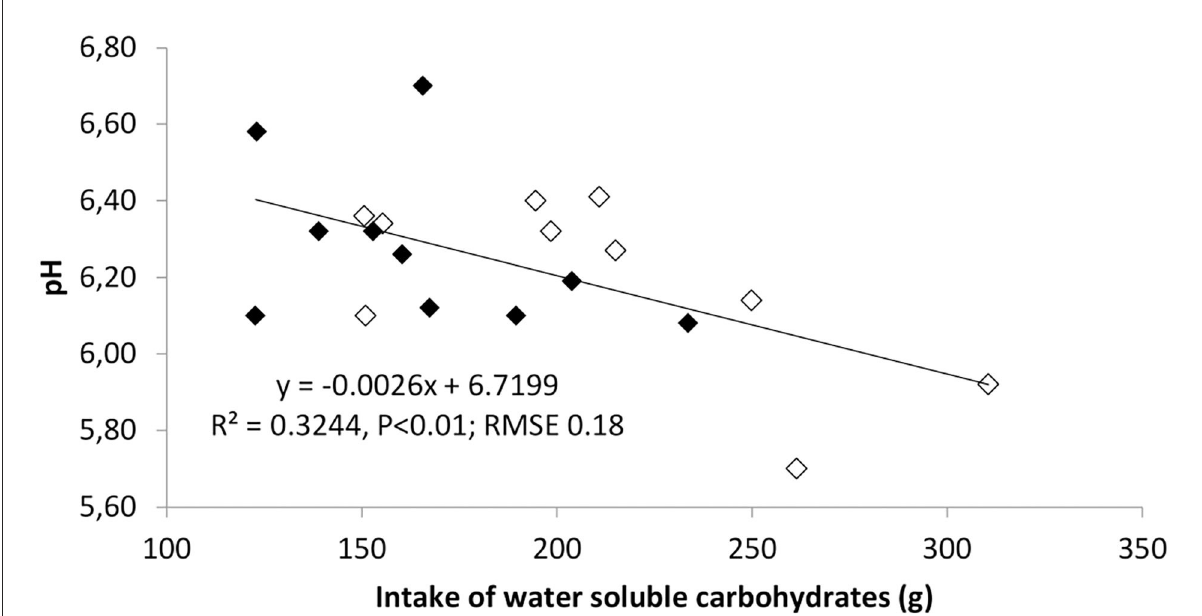
FIGURE1 Regression analysis of post-grazing levels of a rumen pH on the intake of water-soluble carbohydrates (WSC) from the pasture in ewes allocated to pasture 4h daily either in the morning (AM) or in the afternoon (PM). Data on intake and rumen metabolites refer to last week of the experiment (days 35 and 39 for intake and rumen measurements, respectively). Filled symbols indicate AM and empty symbols PM ewes. n = 10 ewes per